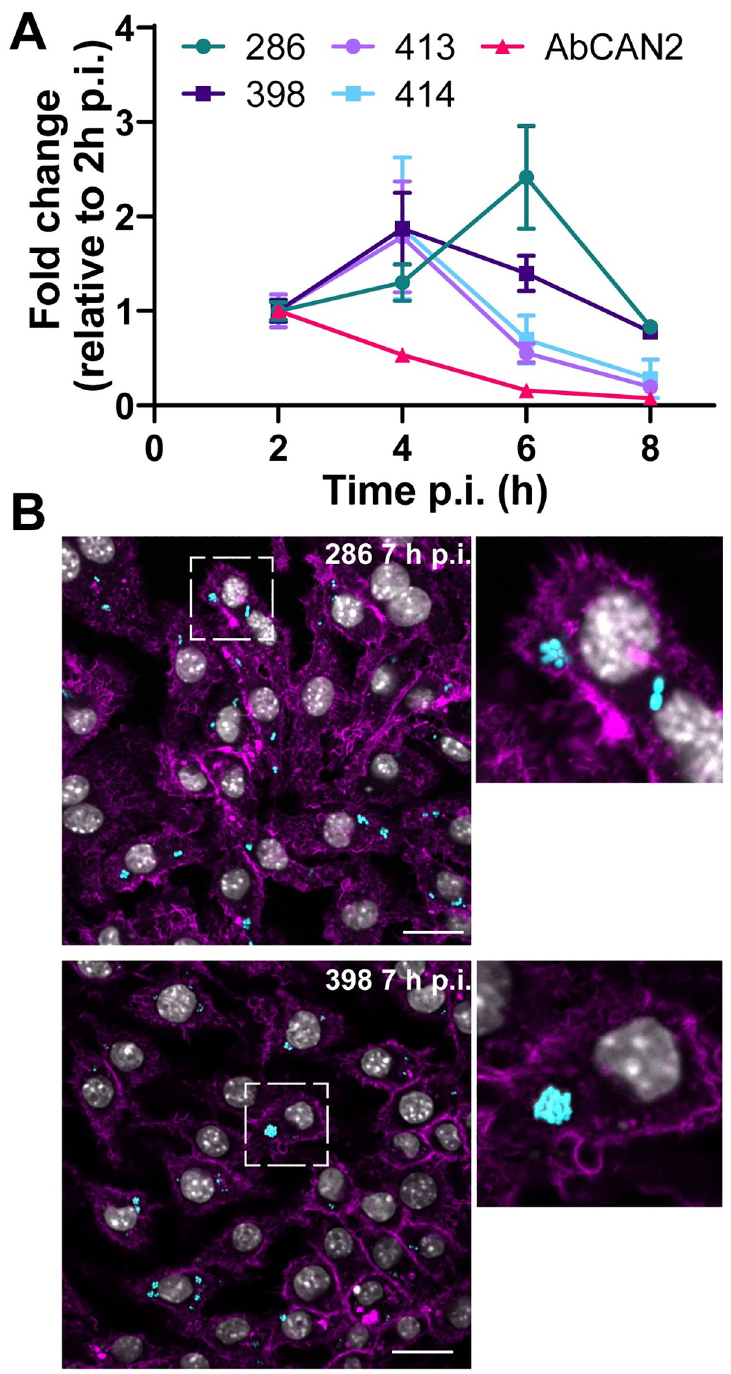
Fig 4. Recent clinical isolates replicate in macrophages. (A) J774A.1 macrophages were infected with the indicated strains and, after phagocytosis, extracellular bacteria were eliminated with antibiotics. After different time points, total numbers of intracellular CFU were determined. Data represent mean and standard deviation values for 3 independent experiments. (B) Representative images of infected cells with the indicated strains. Samples were stained for cell nuclei (grey), actin (magenta) and Acinetobacter GFP (cyan). Insets show a higher magnification of the area indicated by the white box. Individual channels are presented in S5 Fig. Bars: 20 μ m.